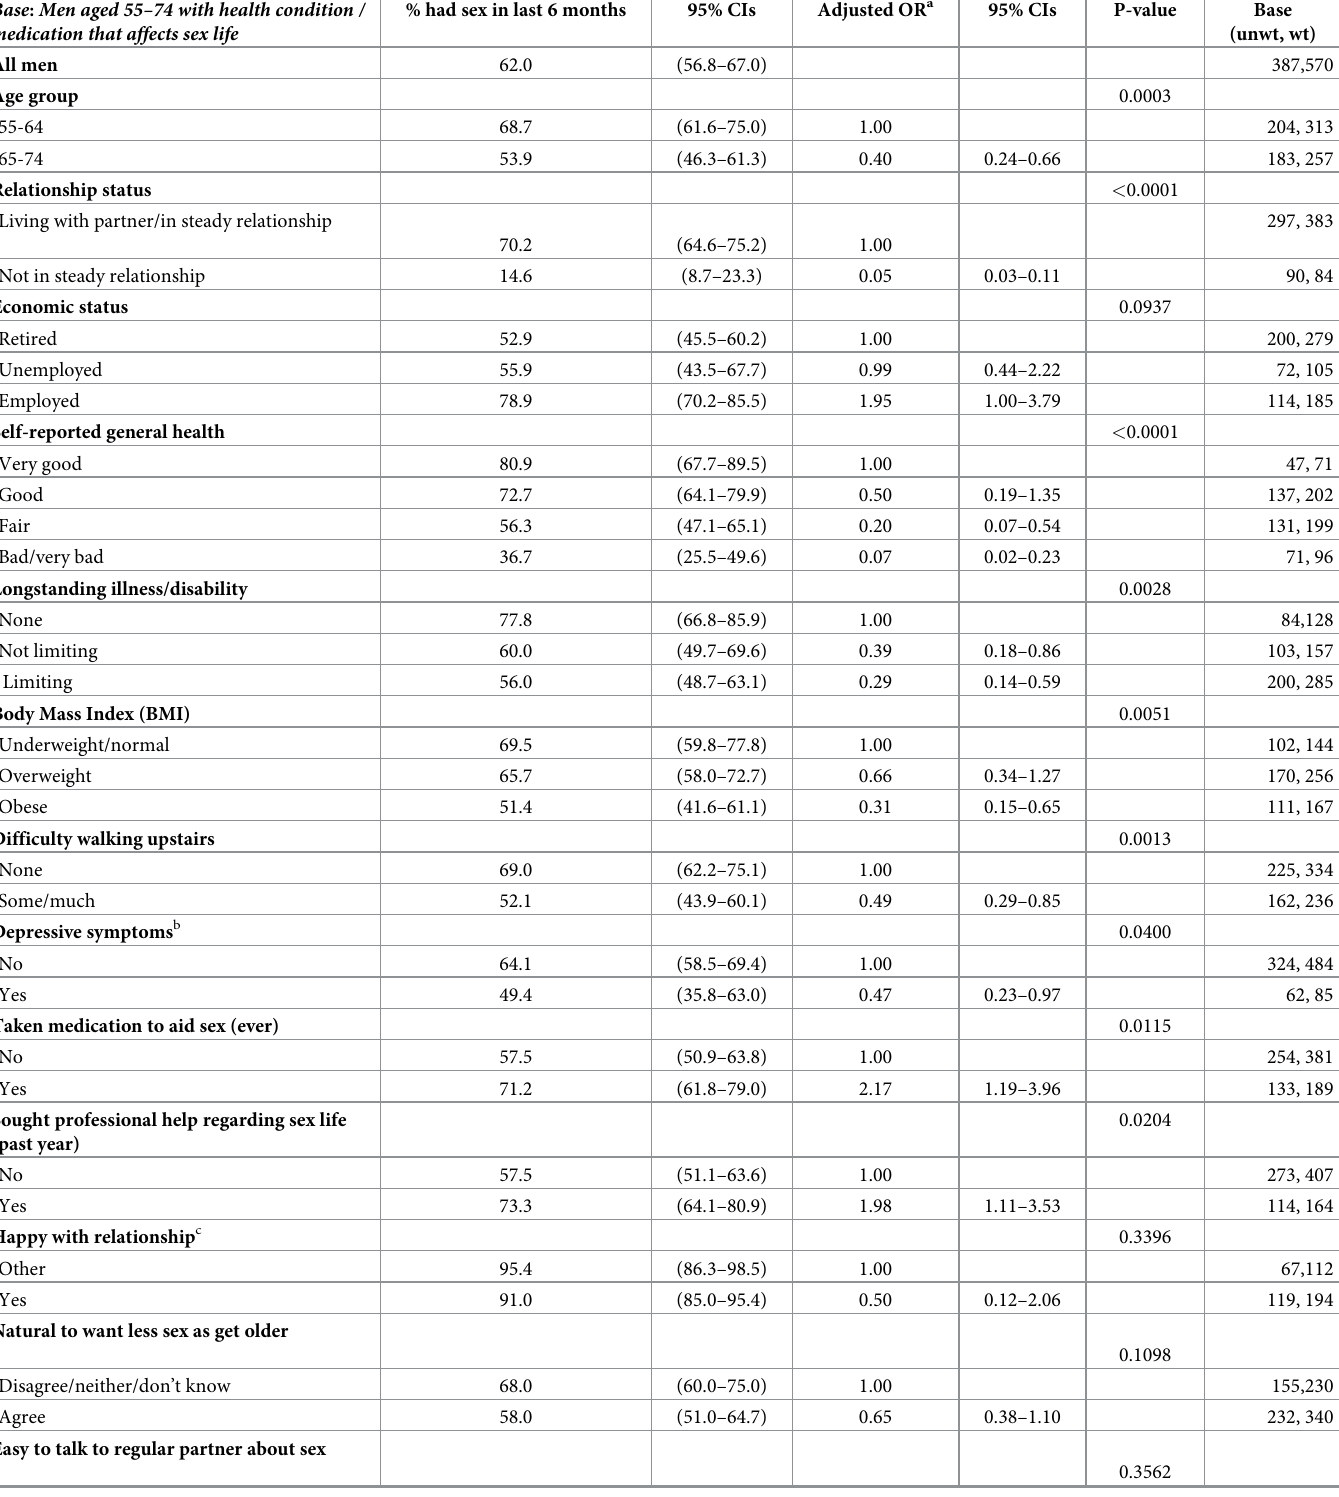
Table 3. Sexual activity in the last 6 months: